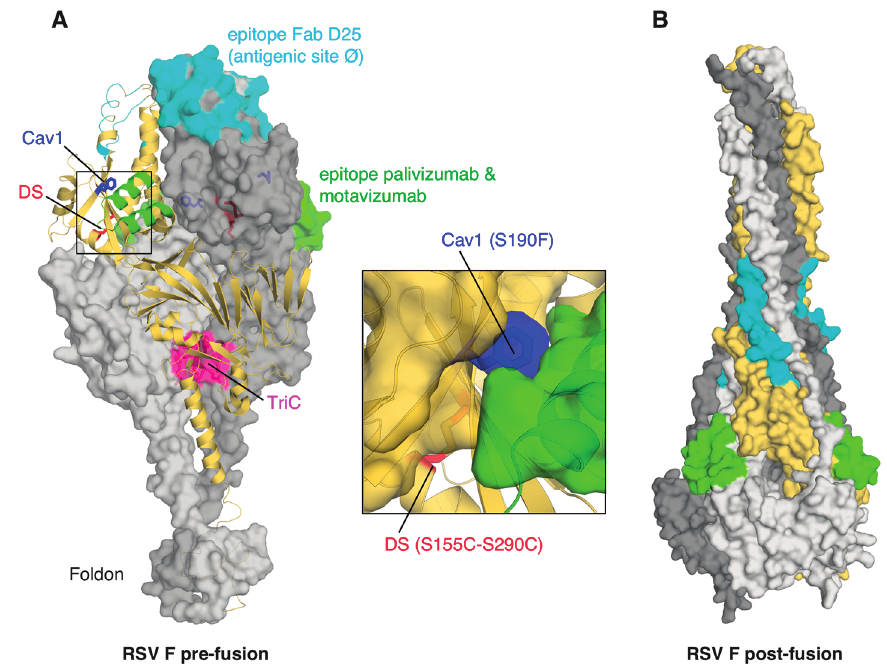
Figure 3. ( A ) Stabilized respiratory syncytial virus (RSV) F pre-fusion (pdb 4MMV) is shown as light and dark surfaces for two chains, and as yellow cartoon for the third chain of the trimer. Sites that were mutated to stabilize the pre-fusion configuration are colored in blue, green, and pink, for the S190F-V207L pair (Cav1), the S155C-S290C double mutant (DS), and the D486H-E487Q-F488W-D489H mutant (TriC), respectively [86]. Known epitope surfaces for Fabs D25, and for palivizumab and motavizumab, are colored in cyan and green, respectively. A zoomed view of the region of DS and Cav1 mutants (central box) provides details of the cavity-filling mutation S190F and of the introduction of the disulfide bridge C155-C290; ( B ) Post-fusion RSV F (pdb 3RKI) [79] is shown as surface, color-coded as in panel A